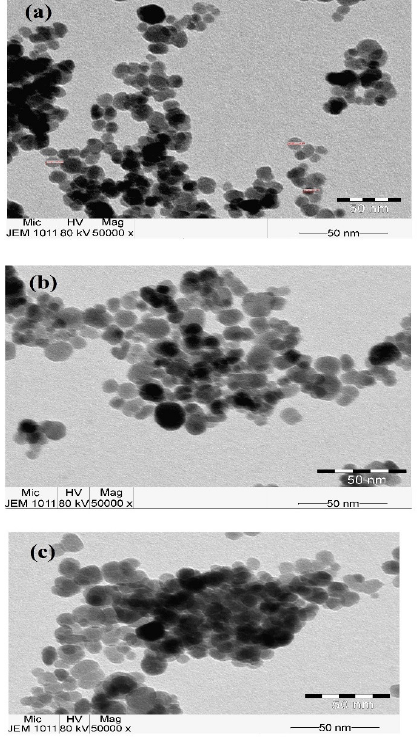
Figure 7. TEM micrographs of Fe 3 O 4 capped with ( a ) EOA, ( b ) ELOA and ( c ) ELNA.